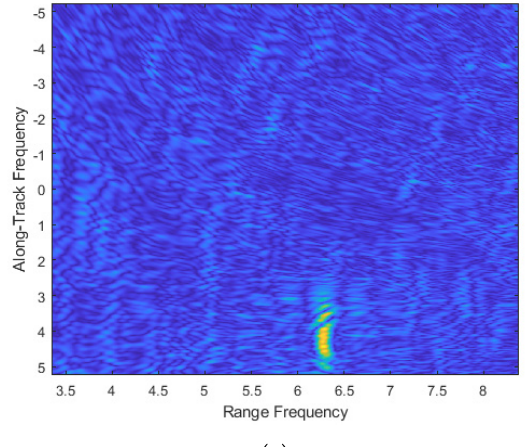
Figure 11. Simulated collected data along SAS of pipeline with leak bubbles: ( a ) Simulated data history of along-track and range; ( b ) simulated data history after pulse compression; ( c ) simulated data history after along-track compression.